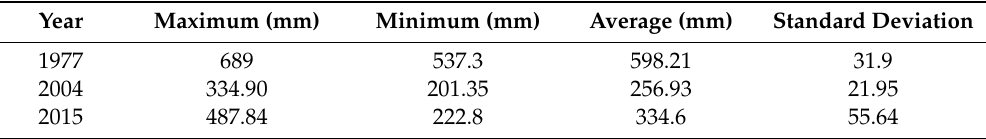
Table 7. Statistical characteristic value of rainfall in the JYG watershed in 1977, 2004 and